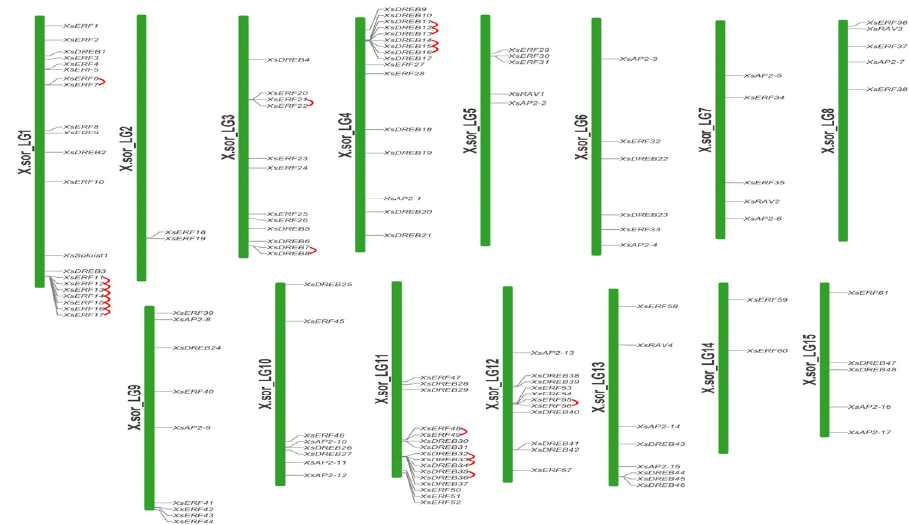
Figure 3. Schematic diagram of AP2/ERF gene chromosome distribution in yellow horn. The XsAP2/ERF genes were located on 15 chromosomes, representing gene positions by proportion. A line indicates position of a gene on each chromosome. The red line between the two gene names suggests that they are tandem repeat pairs. Chromosome numbers are represented on the right side of each chromosome.